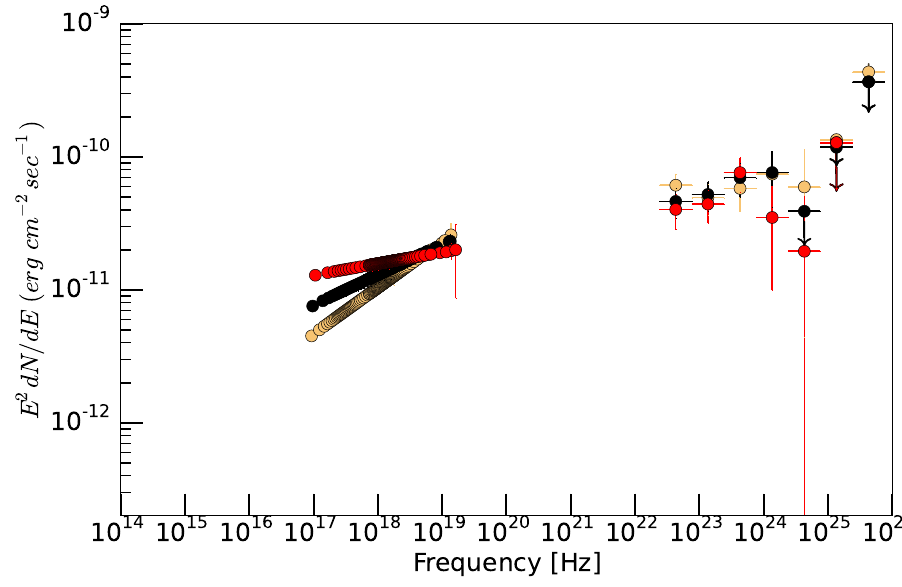
Figure 7. X-ray and Fermi -LAT SEDs for epochs covering XRT- NuSTAR observations in 3 November 2015 ( yellow ), 1 February 2017 ( black ), 4 February 2017 ( red ). Downward arrows shown with some of the Fermi -LAT points indicate upper limits.